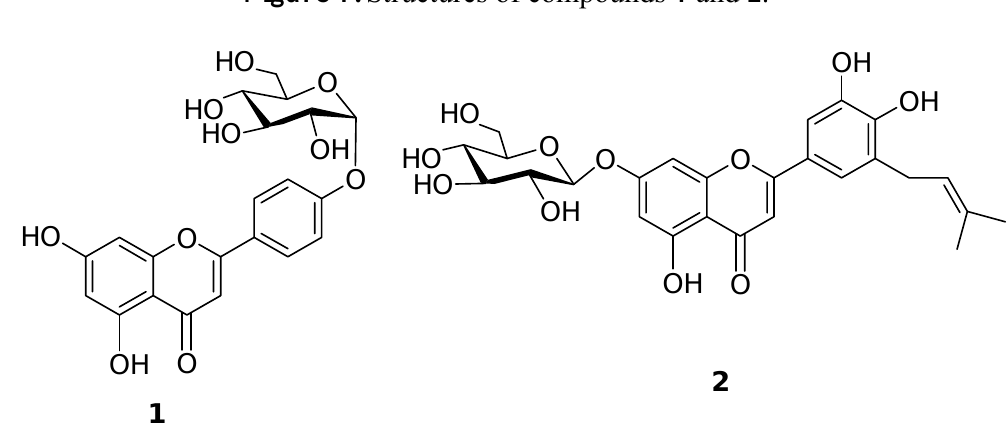
Figure 1. Structures of compounds 1 and 2